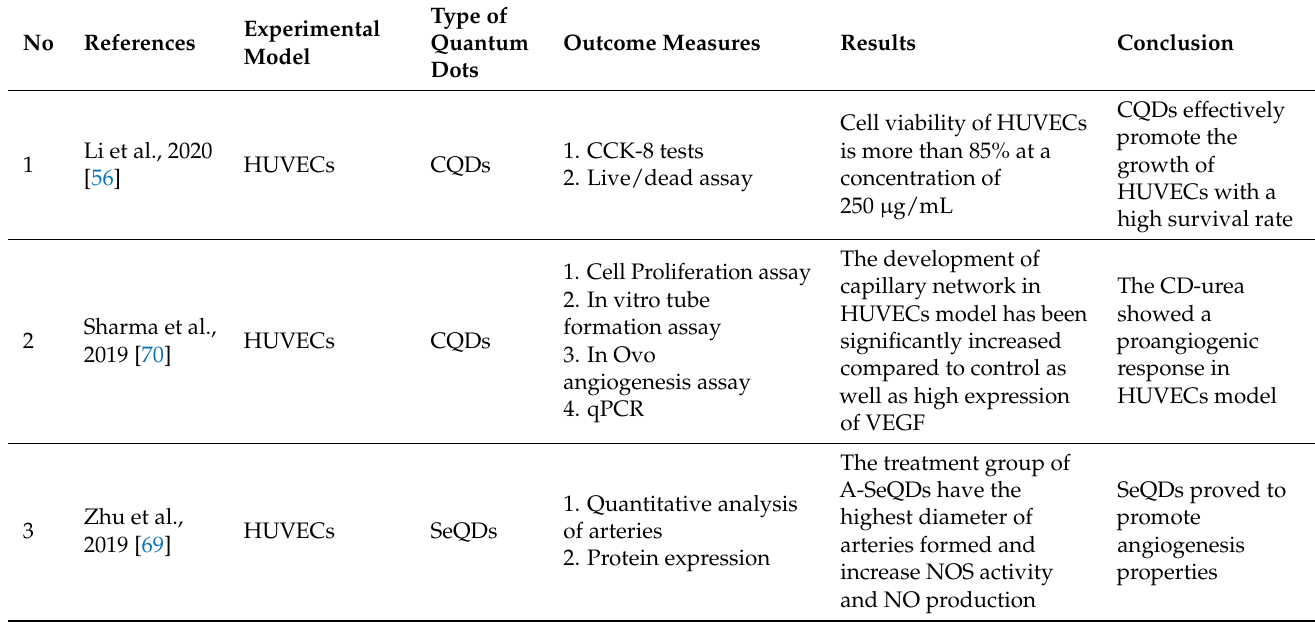
Table 4. Effect of quantum dots to